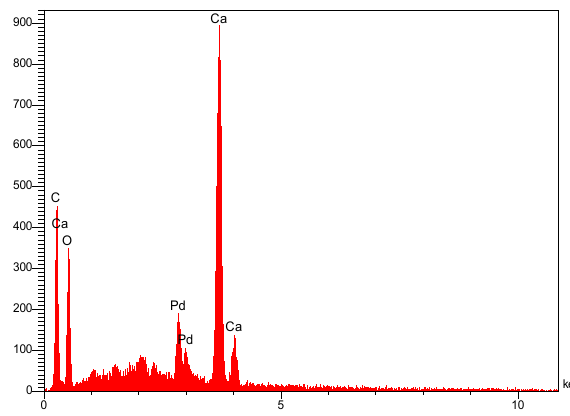
Figure 7. EDS spectrum of Pd/coral reef nanocomposite.